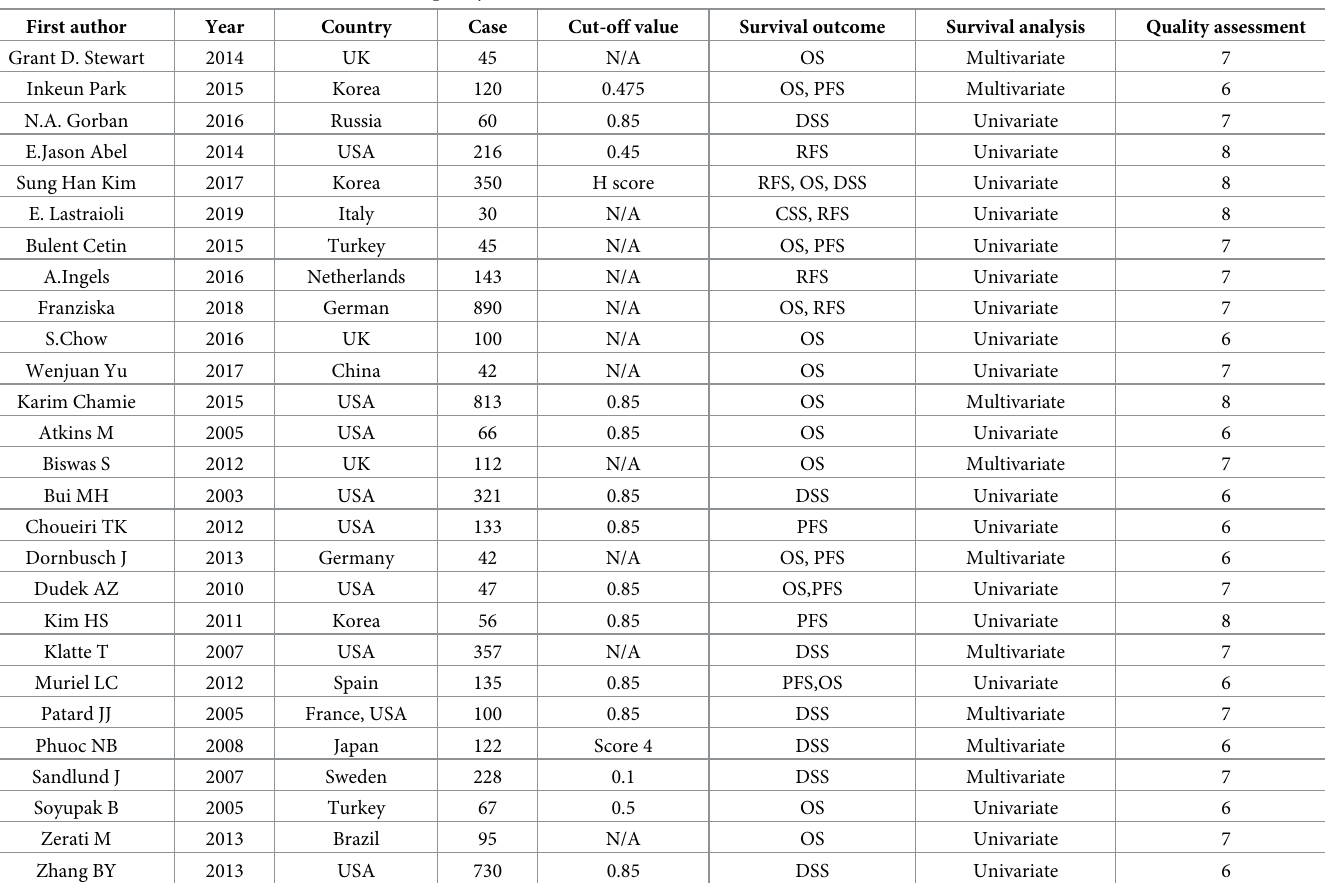
Table 1. Basic characteristics of included studies and quality